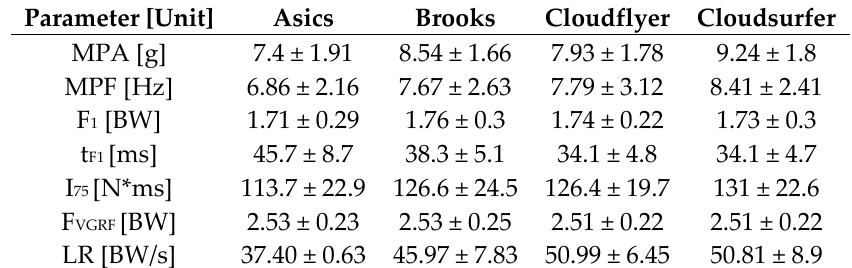
Table 1. Results (mean value ± standard deviation) for the biomechanical test (BIO) with the four types of running shoes.